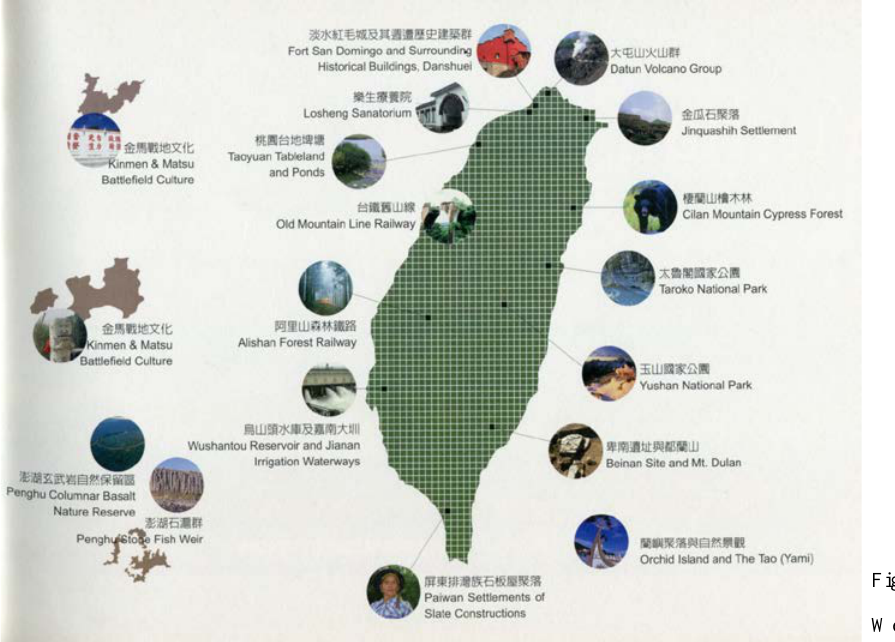
Figure 10: The Taiwan 18 Potential World Heritage Sites